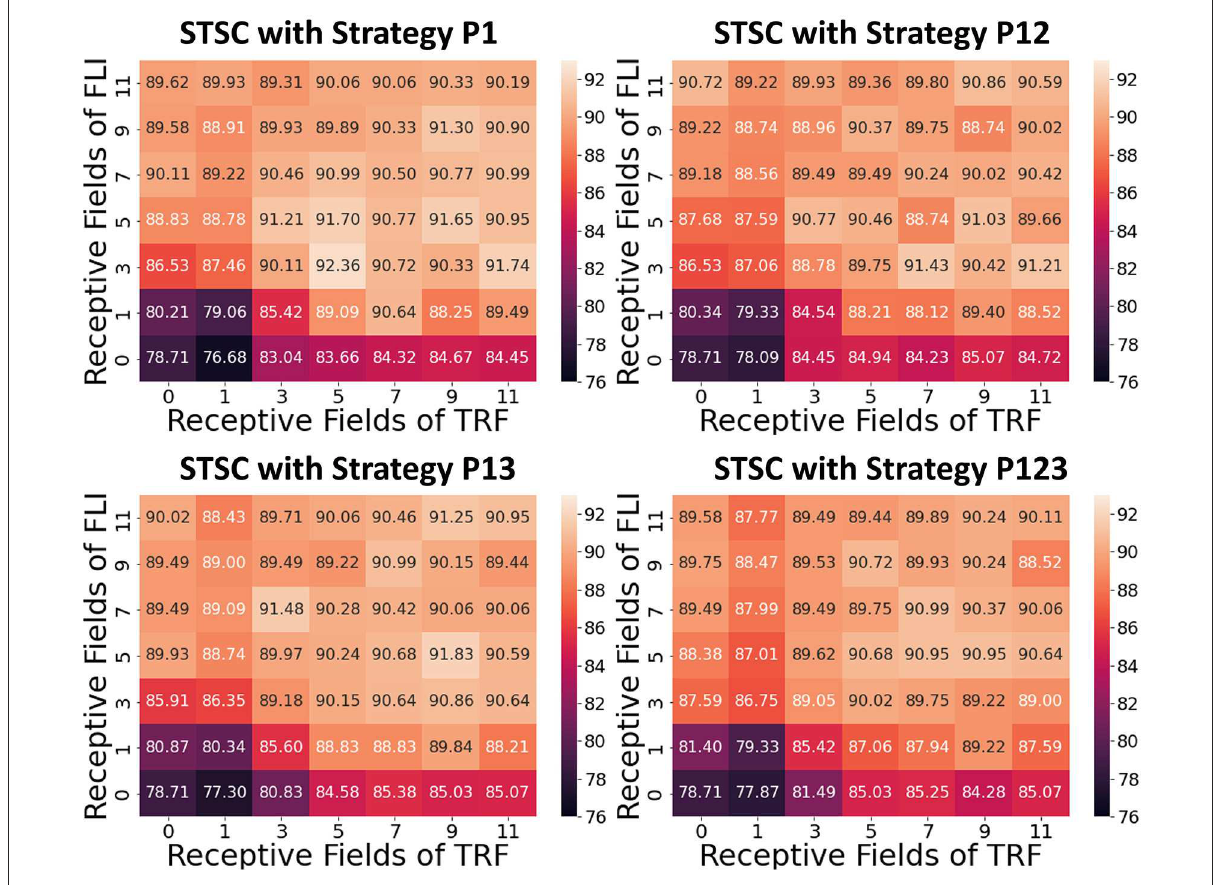
FIGURE7 Influence of receptive fields on SHD. The different experimental results via RFs with